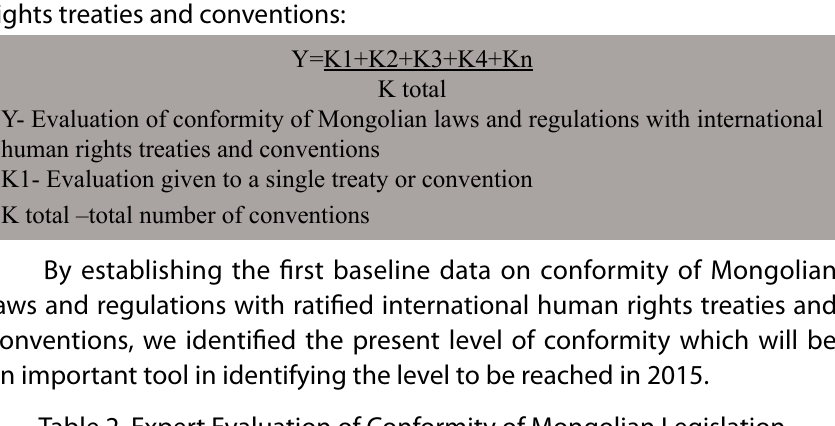
Table 2. Expert Evaluation of Conformity of Mongolian